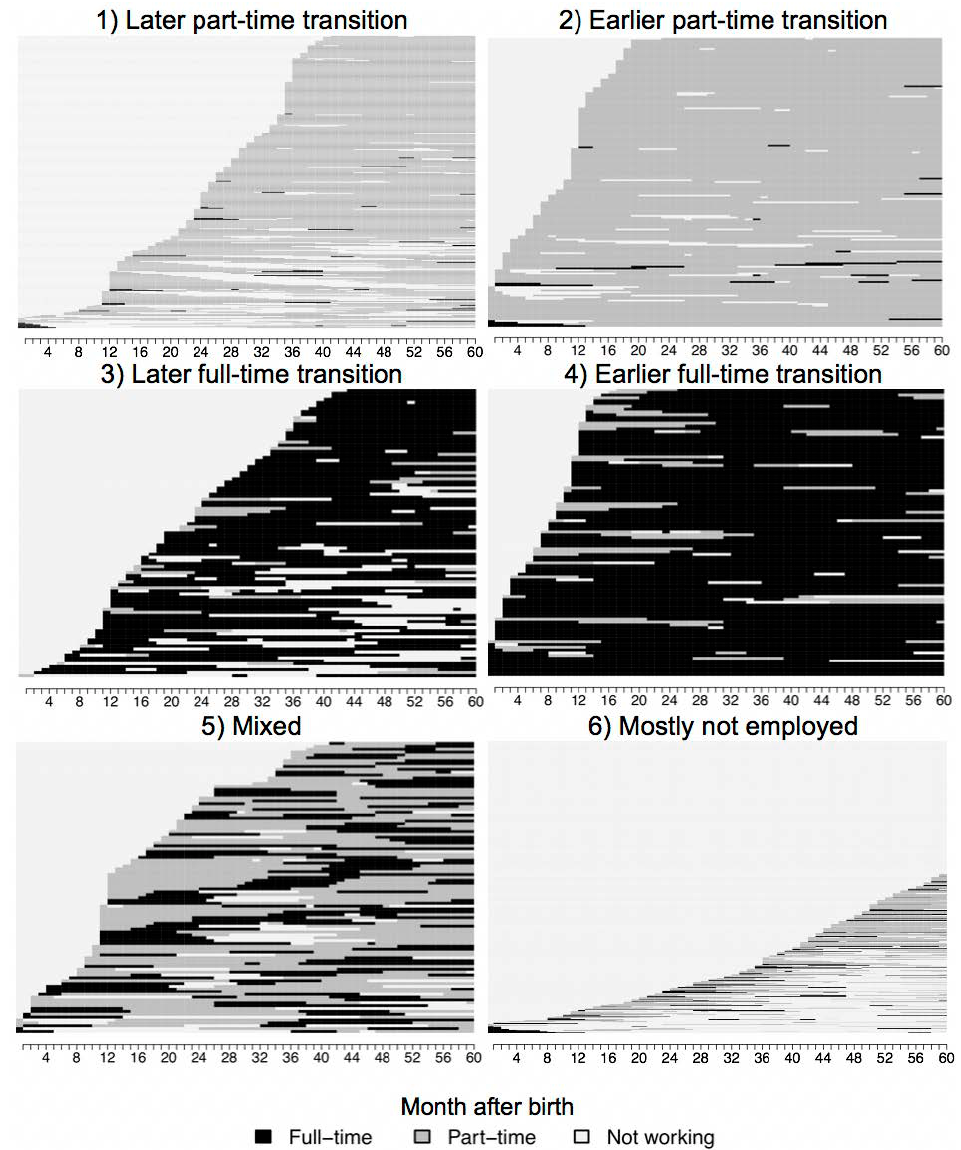
Figure 3 : Clusters of similar maternal employment